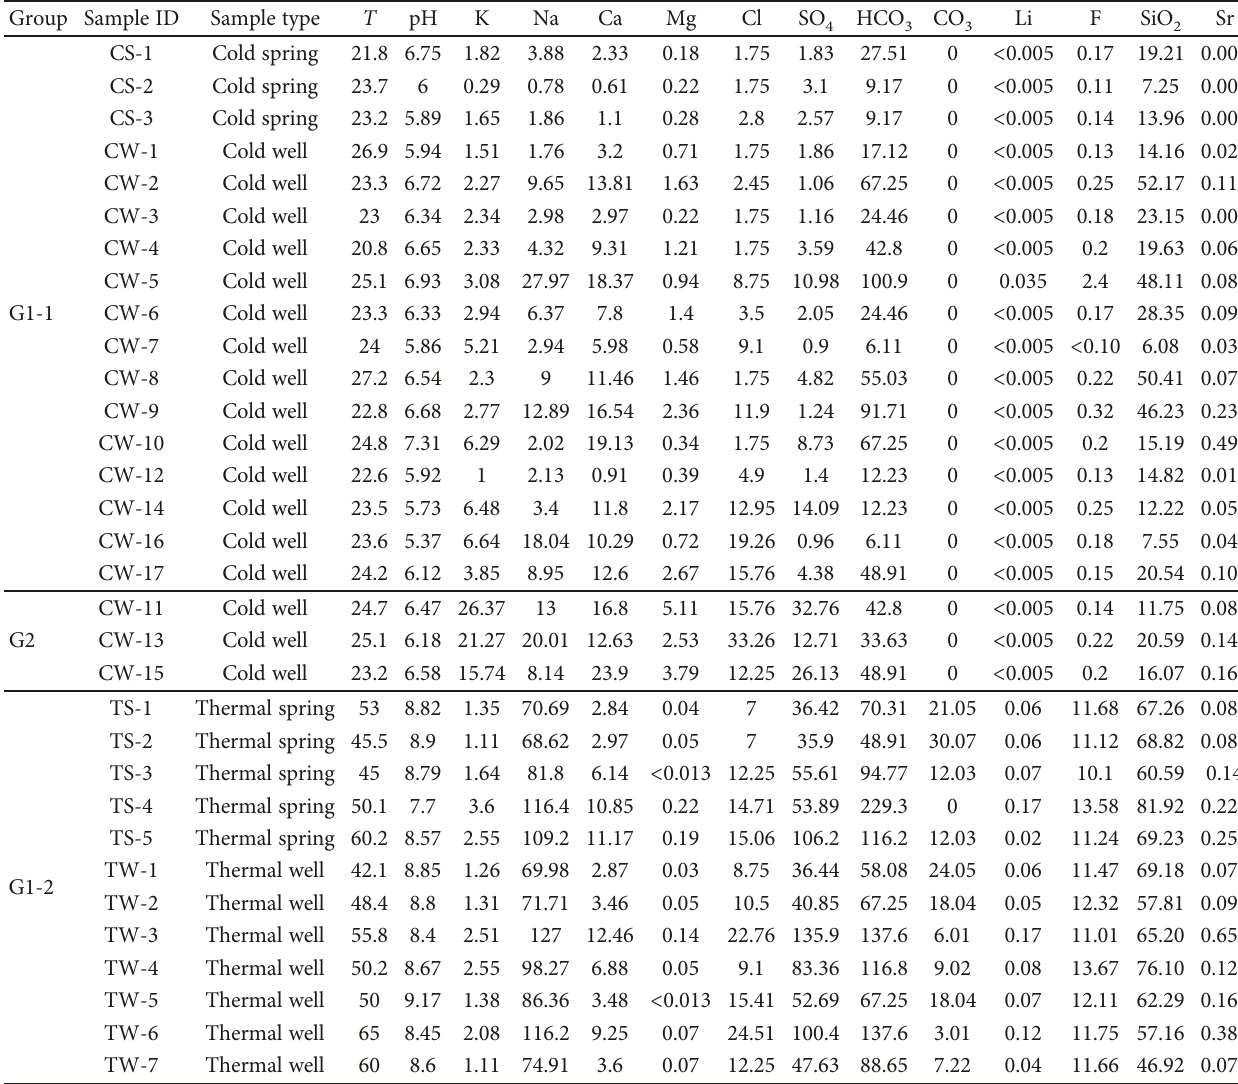
Table 2: Chemical analysis result of water sample of the NZB (in mg/L, except for pH in standard pH units and T in ° C). Group Sample